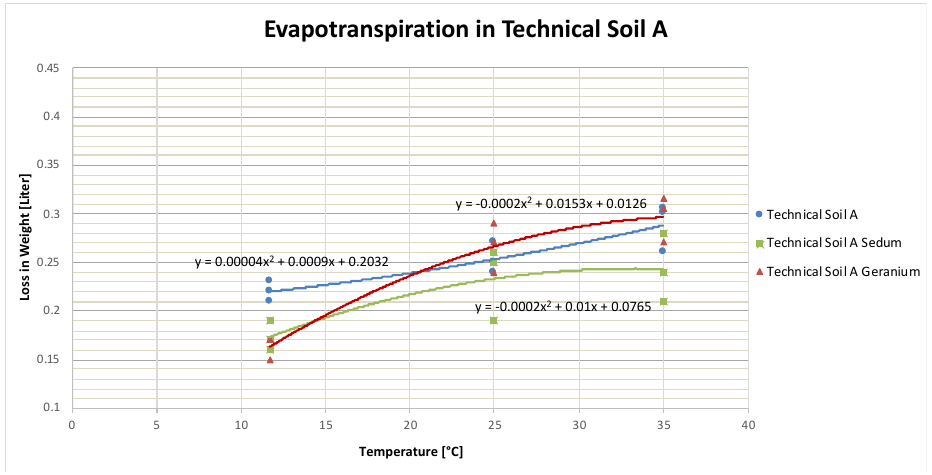
Figure 2. Regression lines were inserted through the differences in weight of any soil combination of technical soil A (with and without planting) in climate scenario I, II, and III, to create equations for calculating evapotranspiration (based on Weiss, 2017